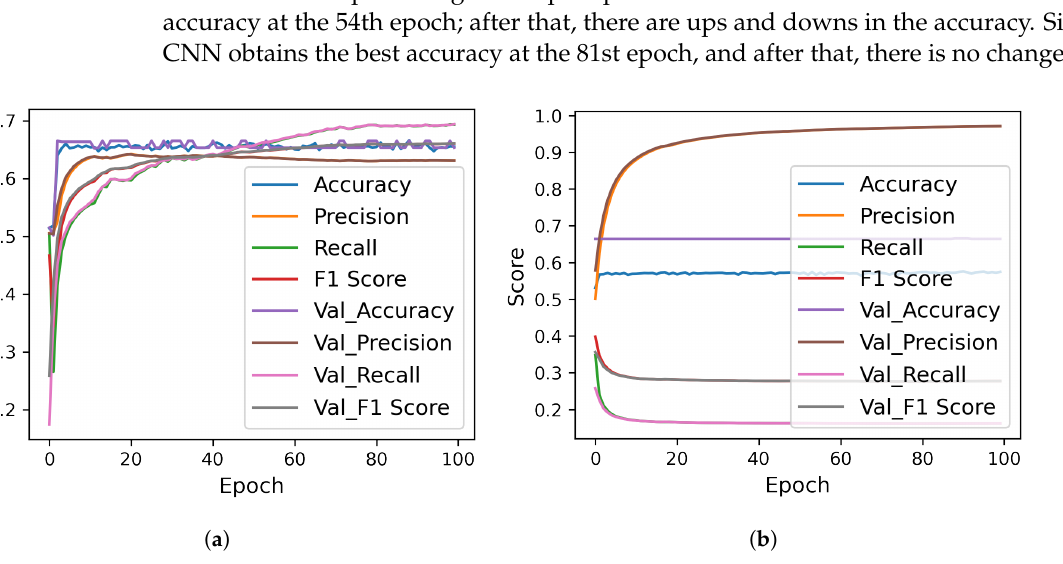
Figure 8. Deep learning models score per epochs. ( a ) LSTM; ( b ) CNN.